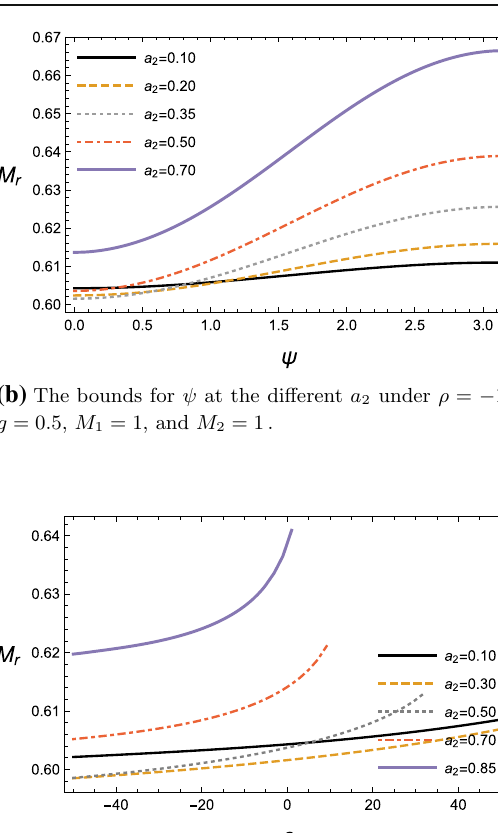
(b) The bounds for ρ at the different a 2 under g = 0 . 5, M 1 = 1, a 1 = 0 . 35, and M 2 = 1.